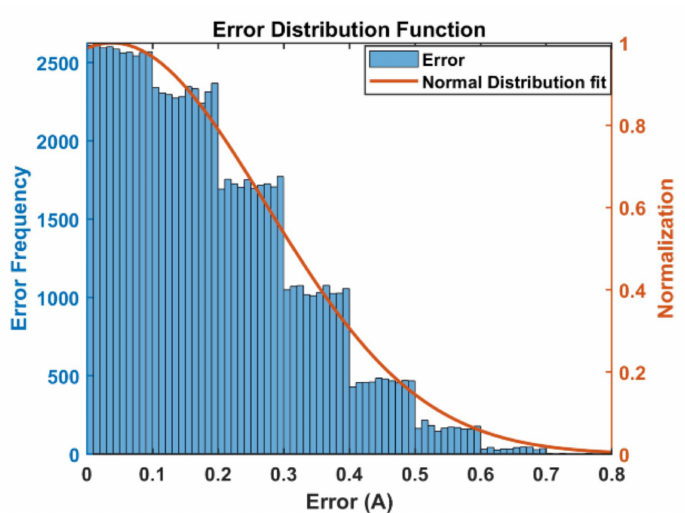
Figure 25. Measurement and simulated data error distribution function over the full testing